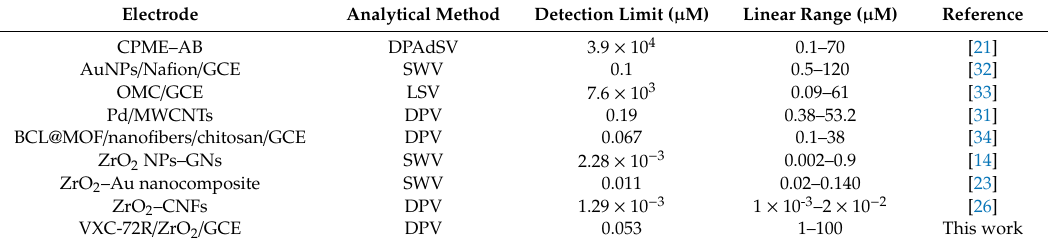
Table 2. Analytical results of MP in real samples using the proposed method ( n =